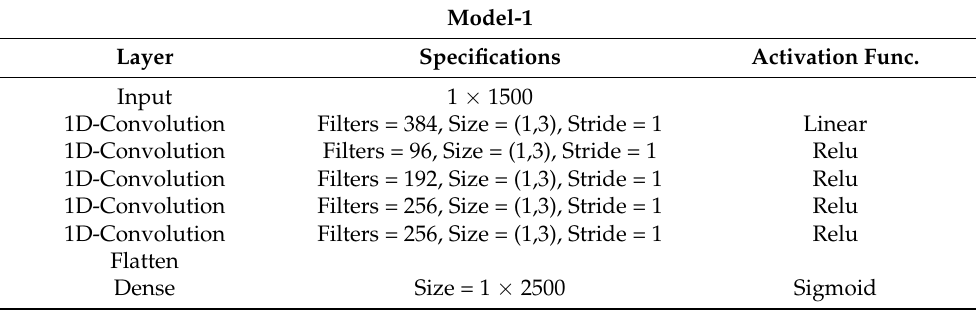
Table 2. Details and architecture of Model-1.